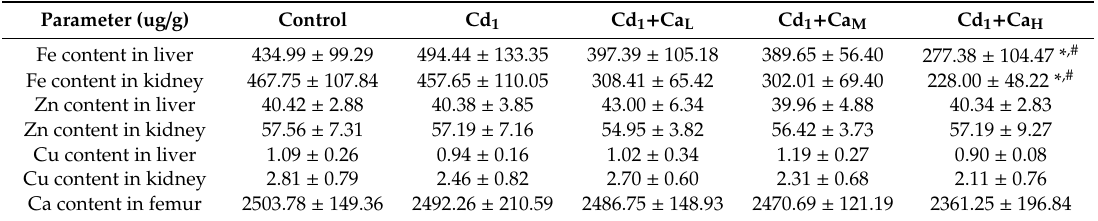
Table 6. Fe, Zn, Cu concentrations in kidney cortex and liver, and Ca concentration in femur in the 90-day oral toxicity study of Ca supplementation exposure to 1 mg Cd/Kg diet (Exp 1).